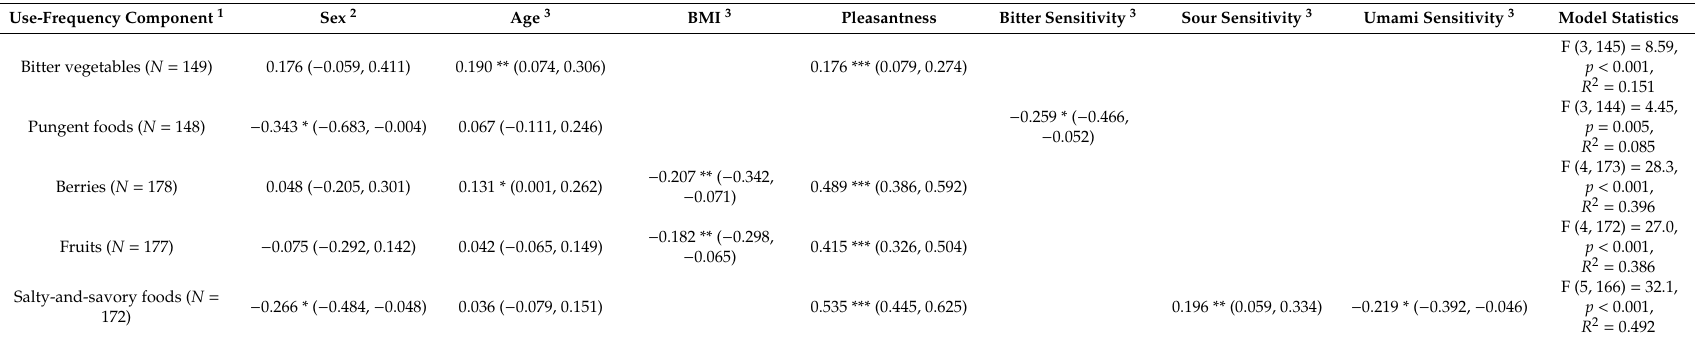
Table 7. The results of hierarchical multivariate linear regression, use-frequency components as dependent variables: unstandardized β coe ffi cients (95% confidence intervals) and model